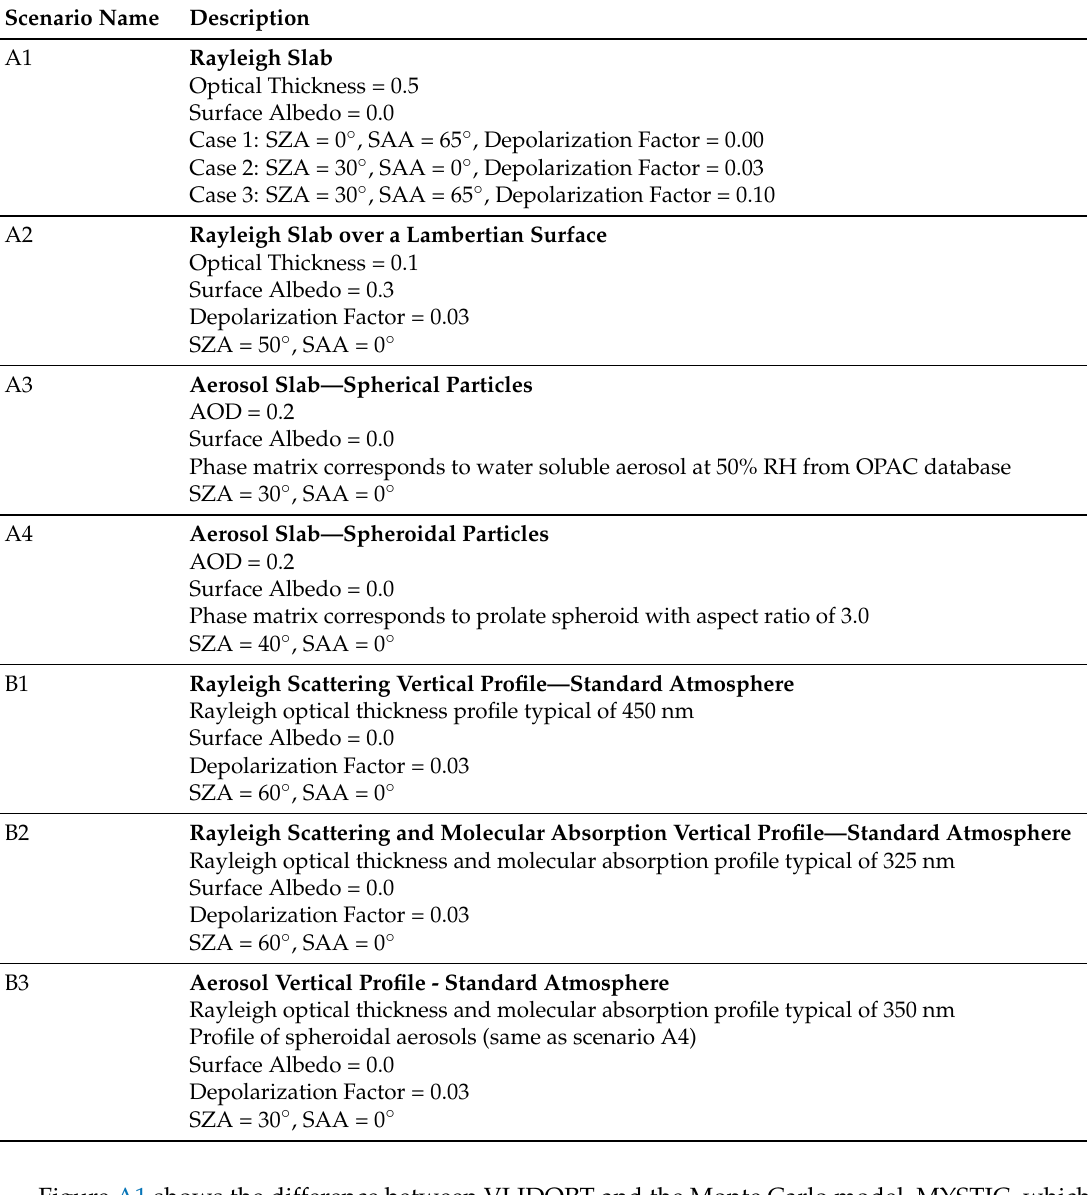
Table A2. Benchmark intercomparison scenarios. Viewing zenith angles range from 0 ◦ to 80 ◦ with